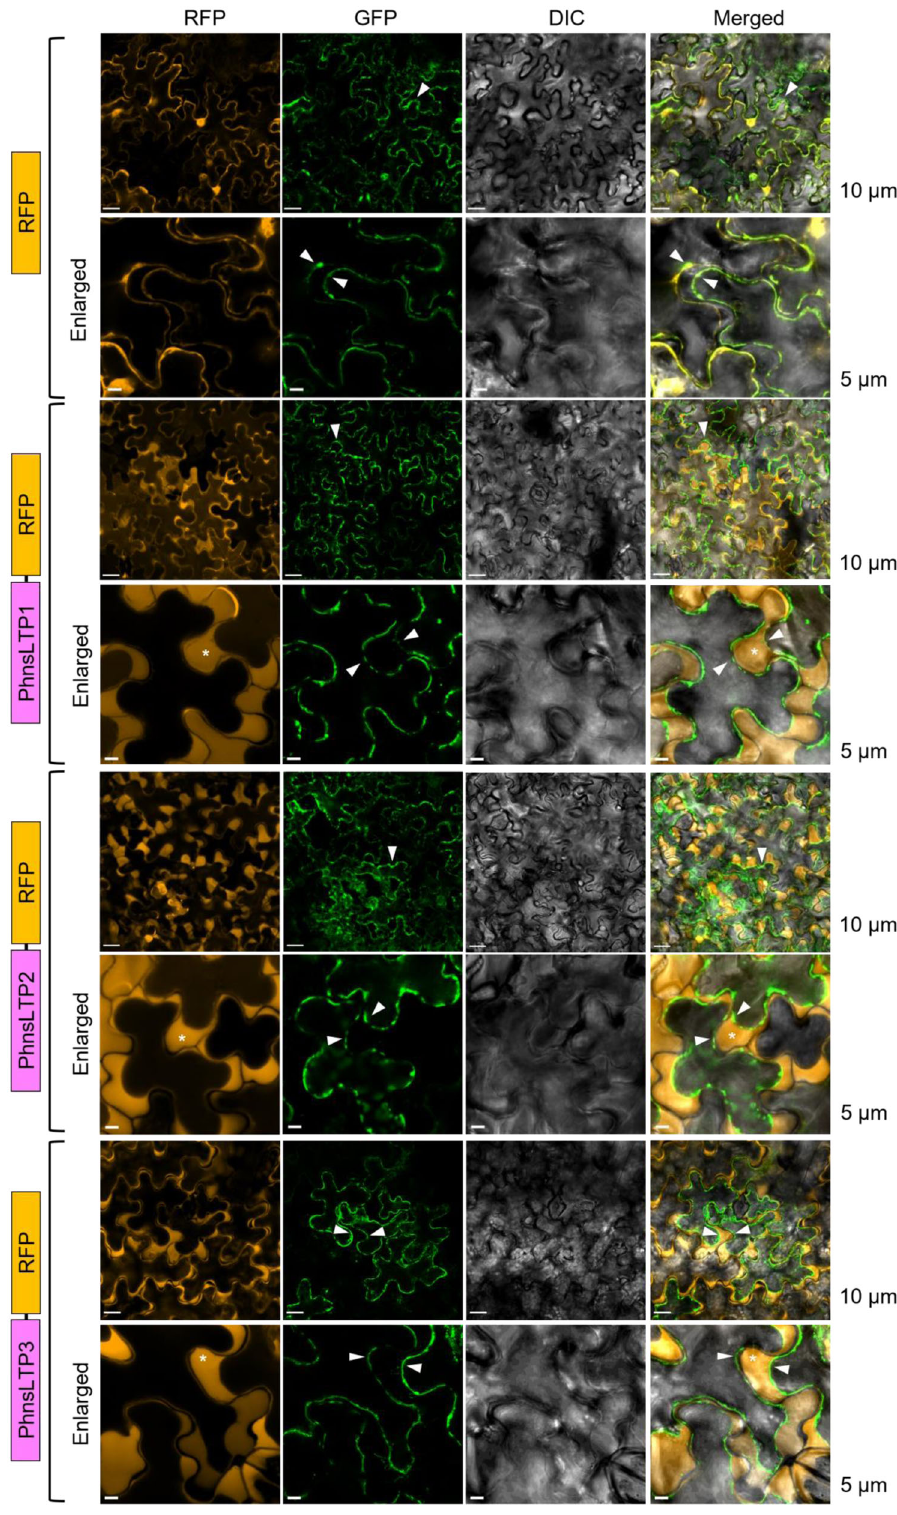
Fig. 2 | Subcellular localization of PhnsLTP1, PhnsLTP2, and PhnsLTP3. PhnsLTP1, PhnsLTP2, and PhnsLTP3 fusion constructs were expressed in N. benthamiana leavesandtheircorrespondingtransientexpressionwasdetected by confocal laser scanning microscopy. “ RFP ” panels (orange) represent signals of PhnsLTP1, PhnsLTP2, and PhnsLTP3 fused fl uorescence proteins; the “ GFP ” panels (green) represent signals of the plasma membrane marker protein, AtPIP1:GFP;theDICpanels(darkgray)showimagesofdifferential-interference- contrast (DIC) microscopy; and the “ Merged ” panels show merged RFP, GFP,